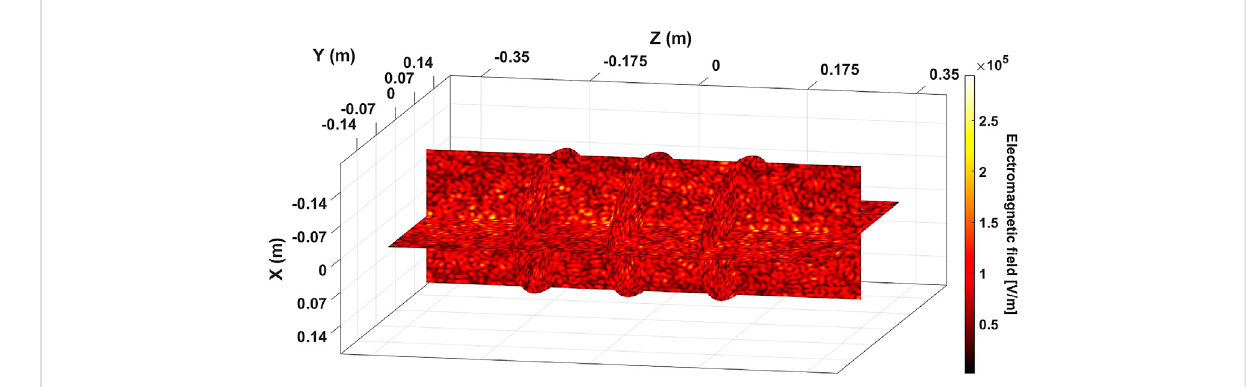
FIGURE 2 Electromagnetic fi eldi n vacuum calculated at the end of the Step0.